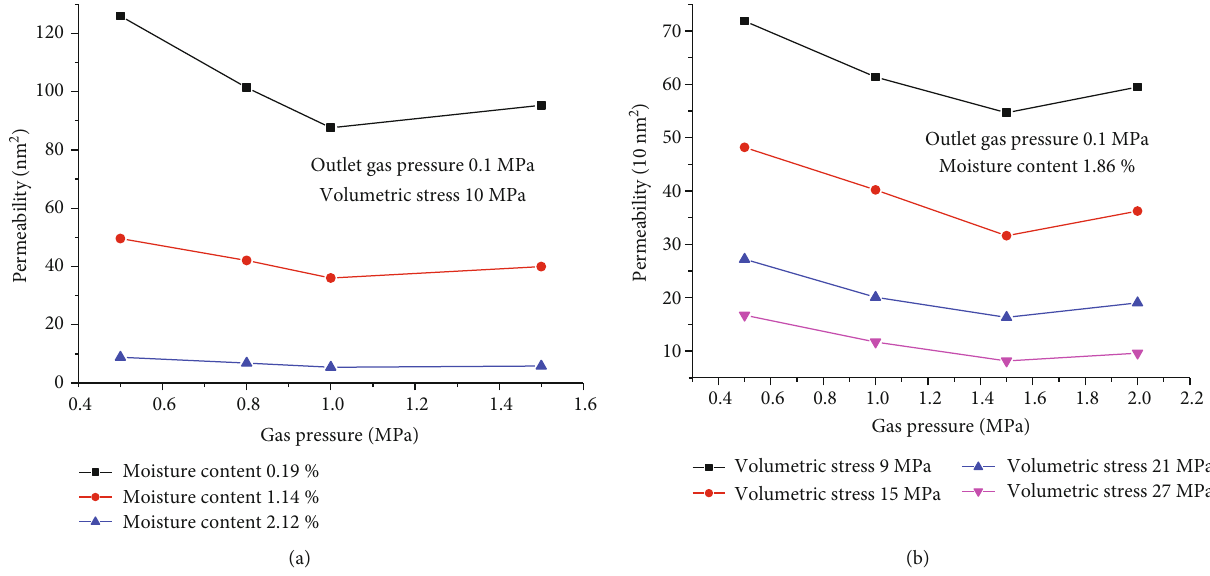
Figure 4: In fl uence of gas pressure on raw coal permeability: (a) Guandi Coal Mine in Qinshui Coal fi eld; (b) Malan Coal Mine in Qinshui Coal fi